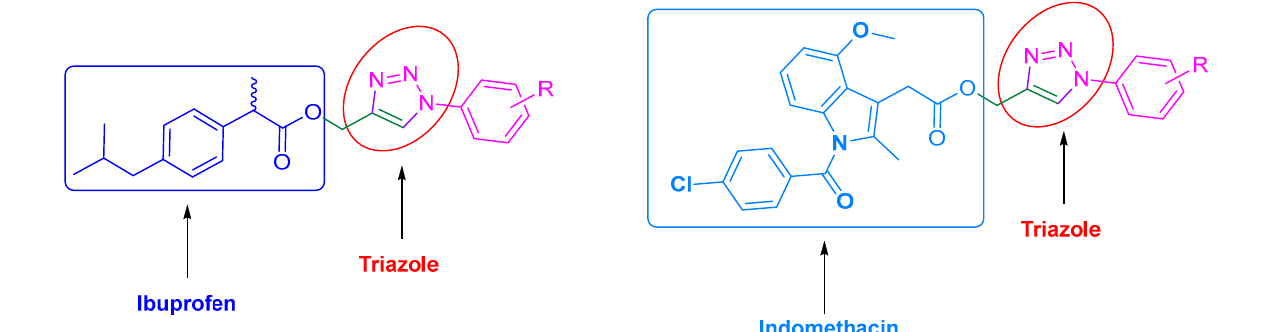
Figure 2. The targeted designed molecules: NSAID conjugates.